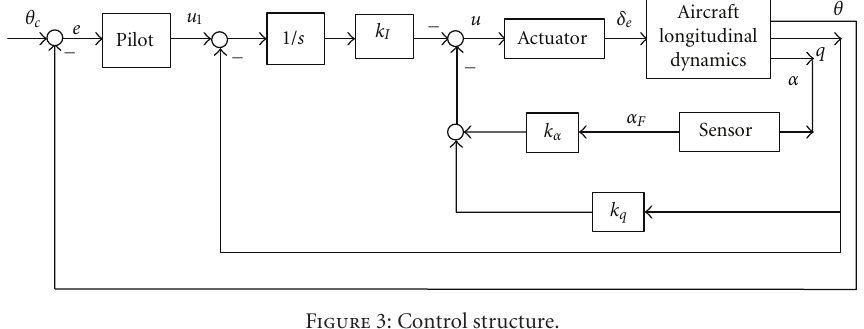
Figure 3: Control structure.